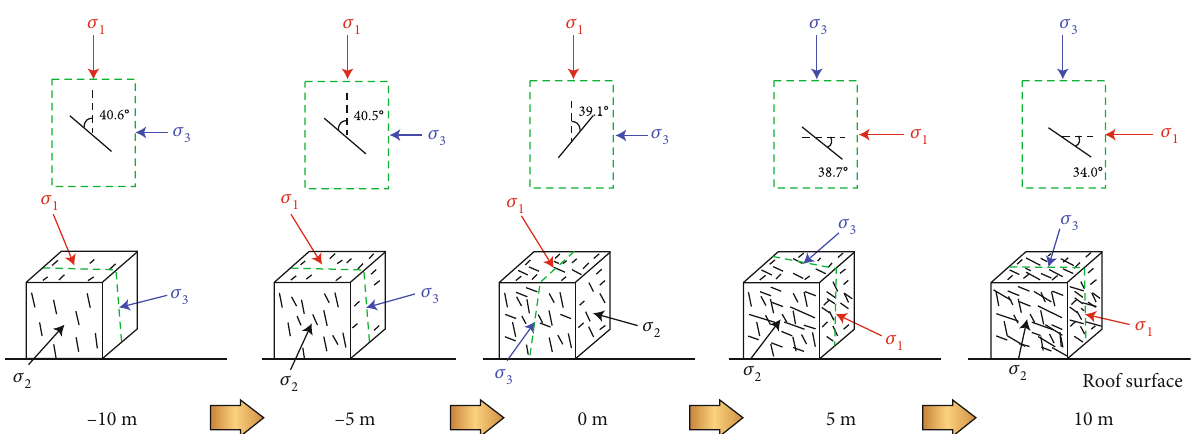
Figure 14: Variation of fracture development at the roof surface at di ff erent excavation distances.